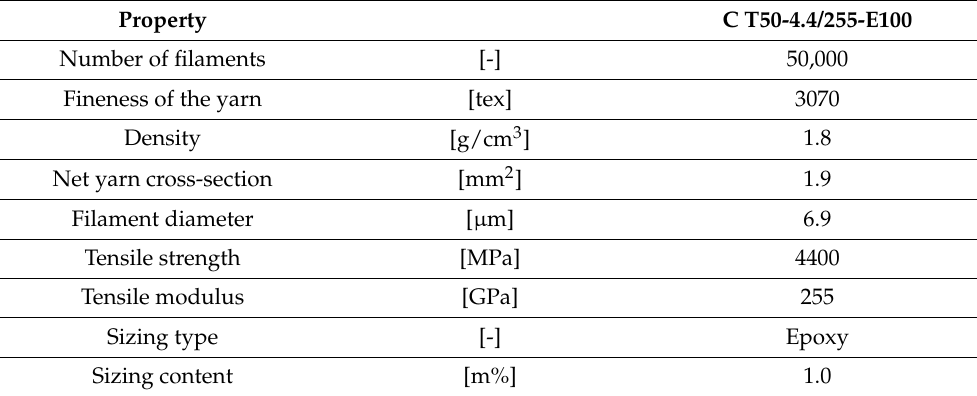
Table 1. Technical data of the used carbon yarns from the manufacturer [43]. Property C T50-4.4/255-E100 Number of filaments [-] 50,000 Fineness of the yarn Density Net yarn cross-section [mm 2 ] Filament diameter [ µ m] 6.9 Tensile strength [MPa] 4400 Tensile modulus [GPa] 255 Sizing type [-] Epoxy Sizing content [m%]